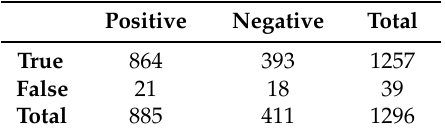
Table 3. Monitoring system accuracy showed in the hens’ detection.